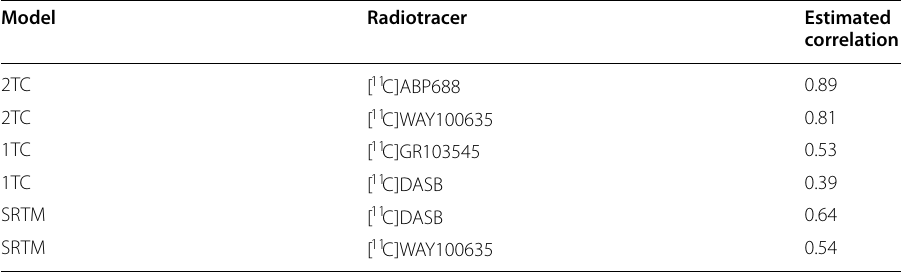
Table 2 Blood flow and binding parameters were positively correlated across all radiotracers and PK models in their inter‑individual correlation matrices estimated by